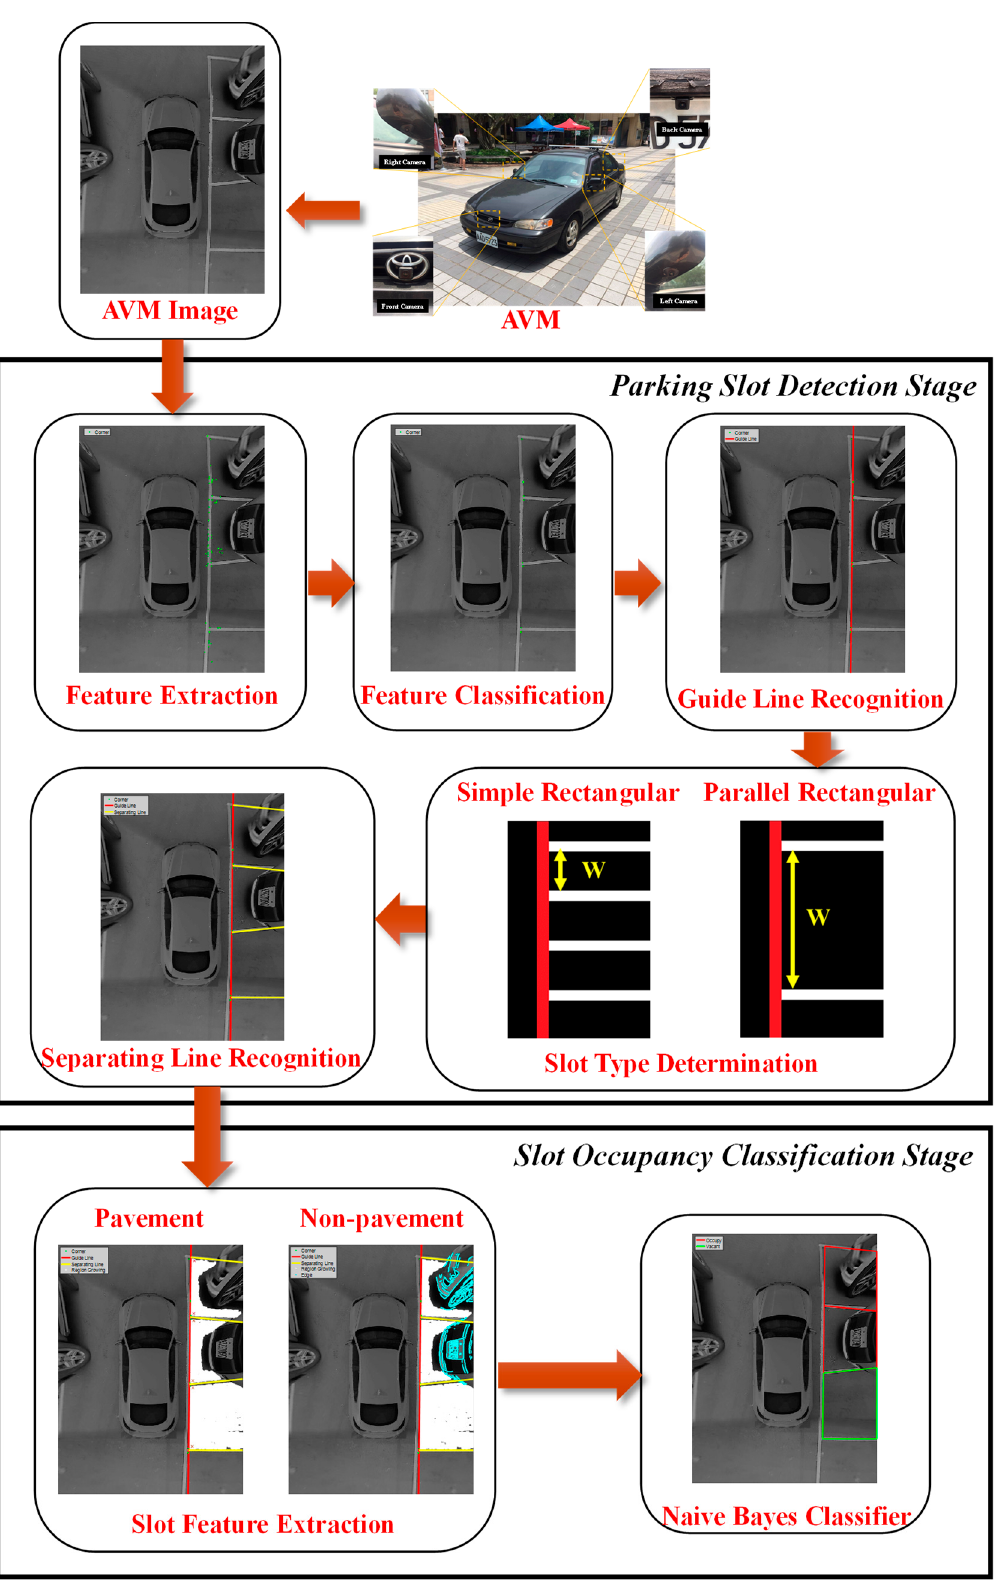
Figure 21. Experimental process.